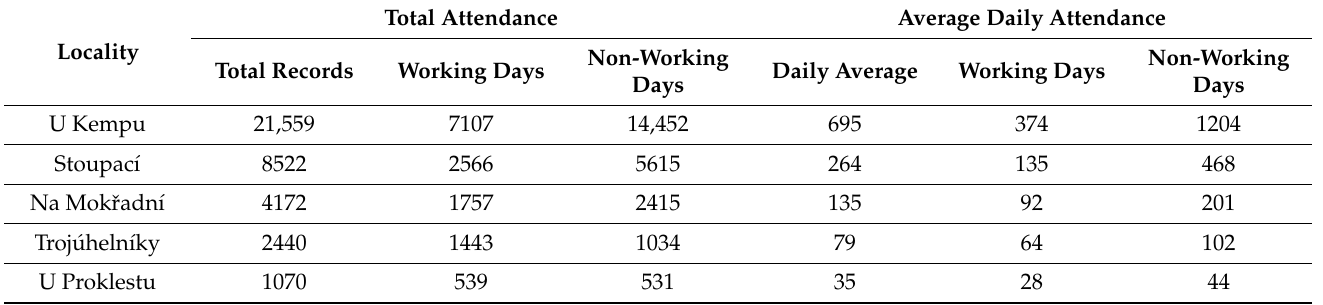
Table 1. Overall monitoring results of visitors on selected forest roads in the Training Forest Enterprise Kˇrtiny MENDELU during the period 15 June–15 July (calibrated data).